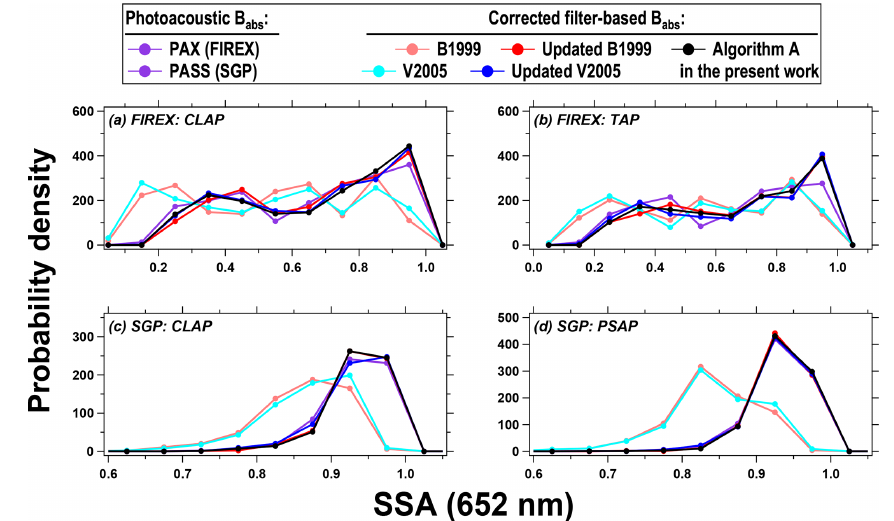
Figure 11. The frequency distribution of SSA (652nm) calculated for different instrument–correction combinations of B abs and B scat .